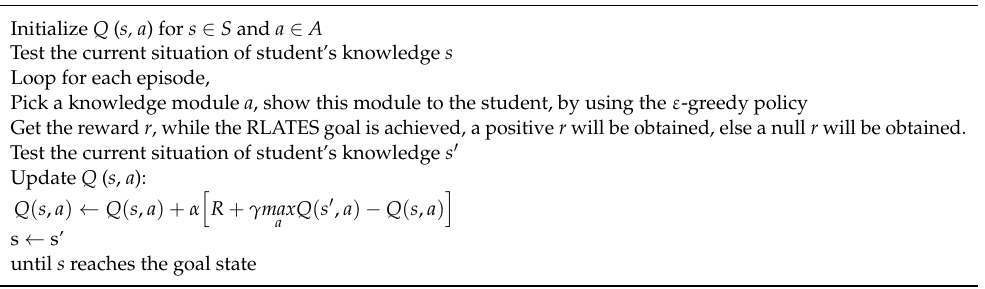
Algorithm 1 Apply reinforcement learning algorithm to